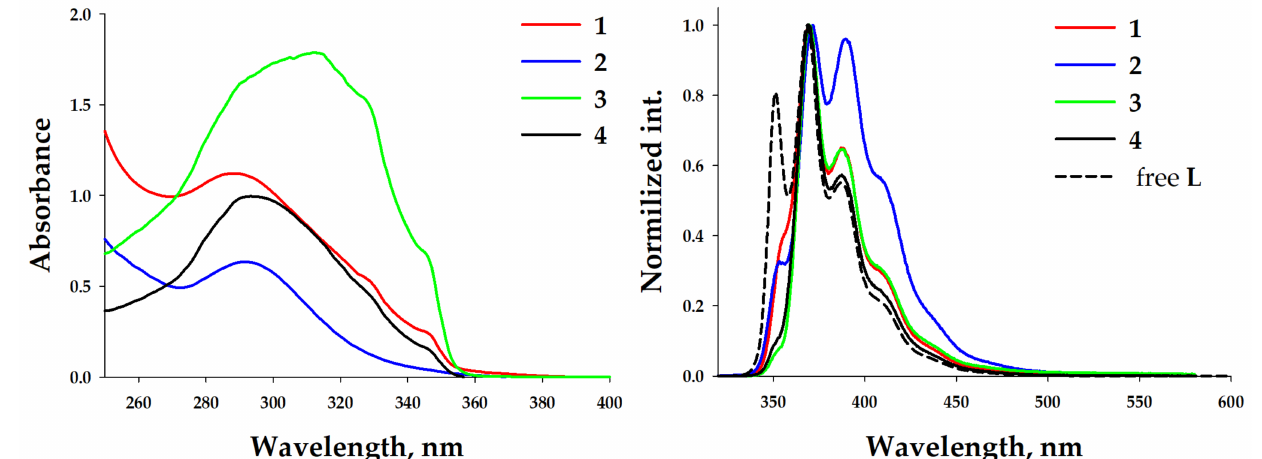
Figure 4. Left: UV-vis (left) spectra of complexes 1 – 4 in a DCM solution. c = 10 − 2 M. Right: normalized emission spectra ( λ exc = 325 nm) of complexes 1 – 4 in a DCM solution at 298 K (solid lines) and free L (dashed line). c = 1.2 × 10 − 2 M.